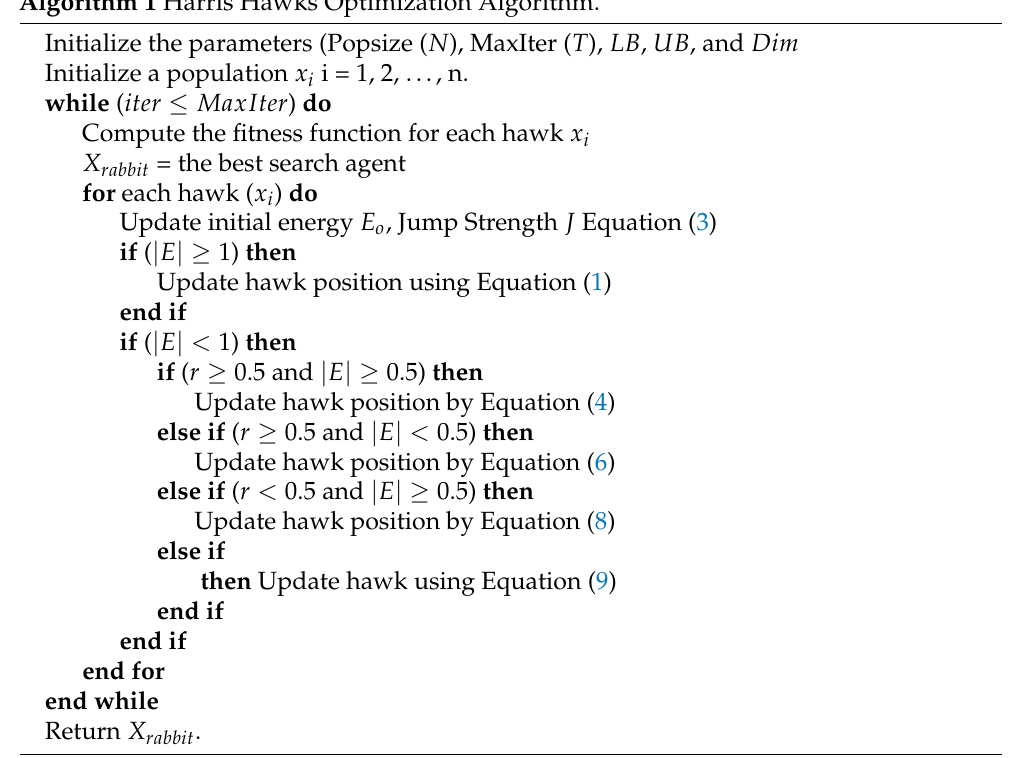
Figure 1. The logical diagram of HHO. Algorithm 1 Harris Hawks Optimization Algorithm